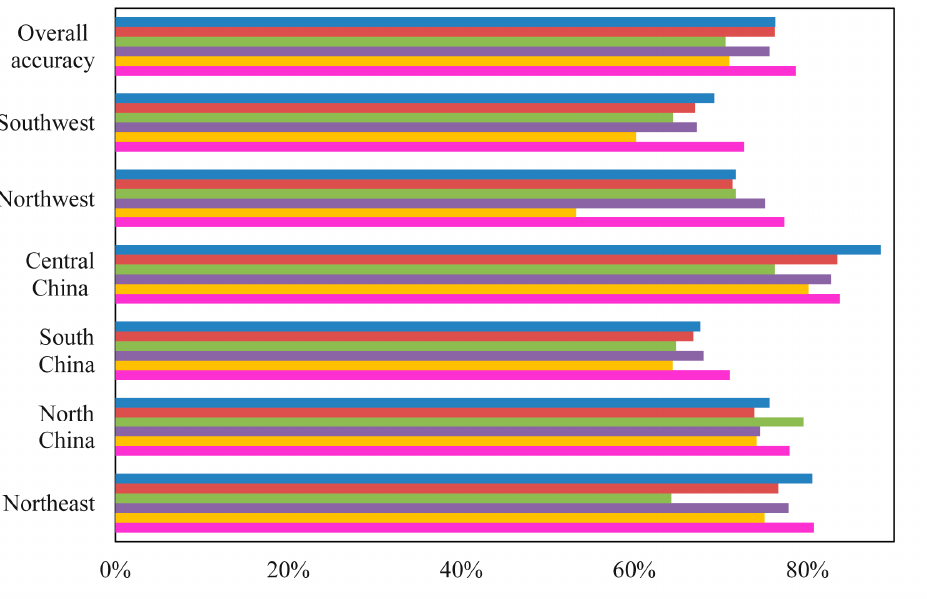
Figure 9. Overall and regional accuracies of the five cropland datasets and the synergy